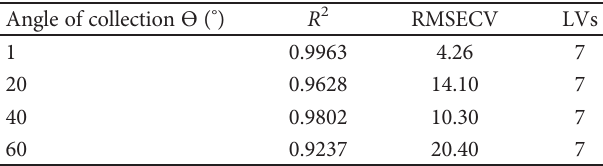
Table 1: PLS calibration parameters for various remote distances analyzed.